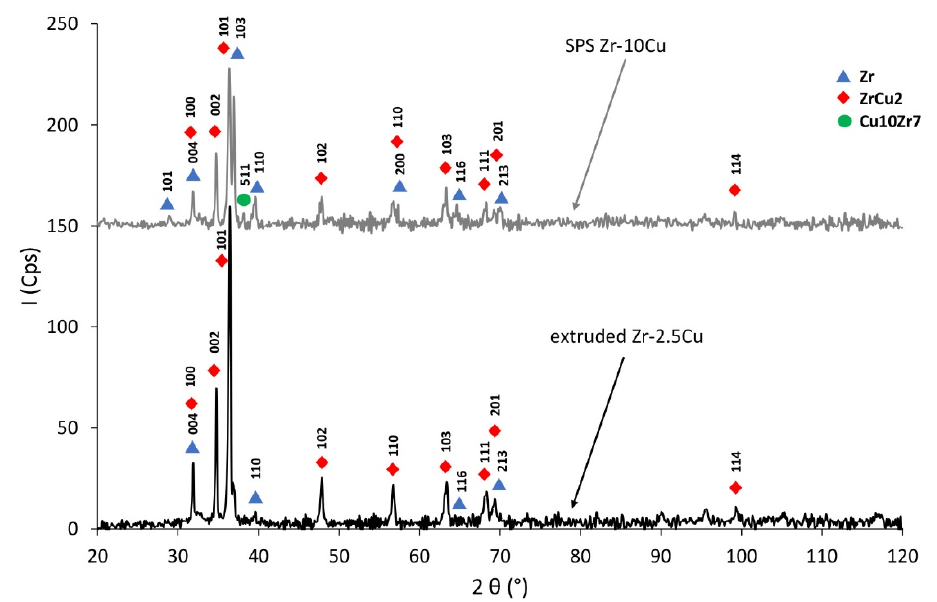
Figure 7. Phase composition of materials: Zr-2.5Cu obtained using the extrusion method and Zr-10Cu obtained with SPS, sintered at 900 °C, 35 MPa, for 1 min in argon.